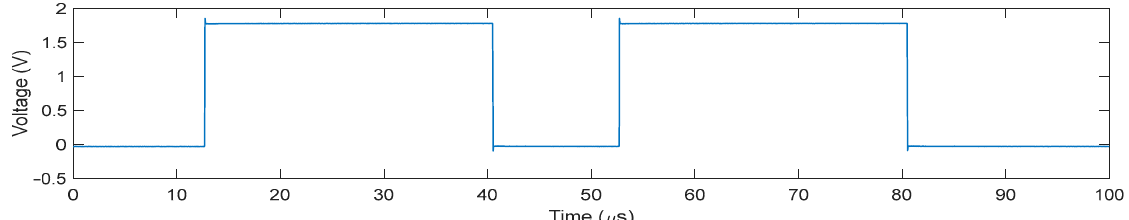
Figure 11. The waveform of the RX phase with two cycles used in the pulse-echo measurement to record the switching glitches at both TX to RX transition and vice versa.